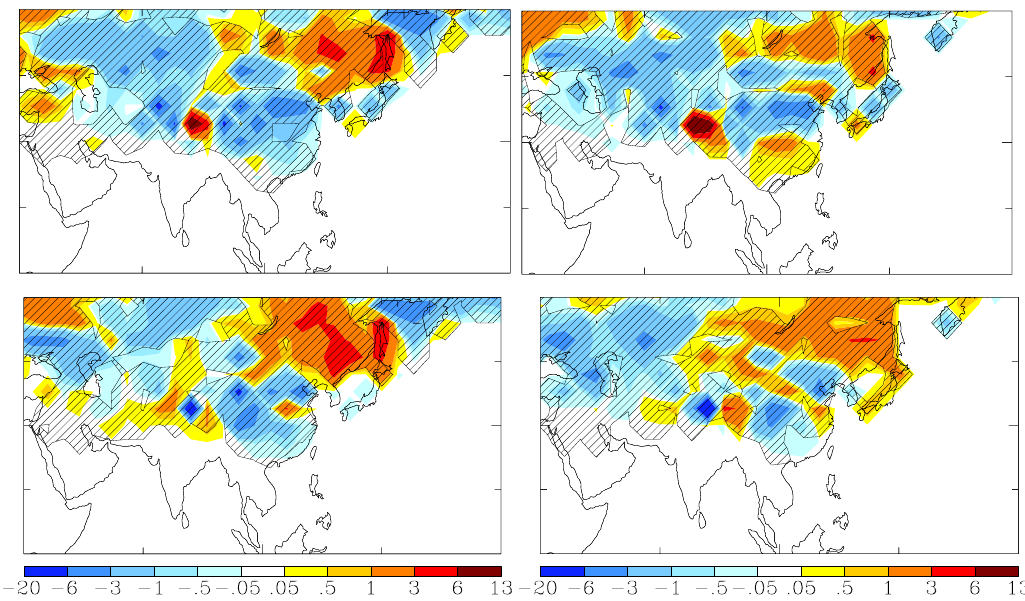
Fig. 2. Average difference in annual snow/ice cover (%) for differences in emissions between 2000 and 1990 with (left panel) and without (right panel) the climate influence for the Beig (top panels) and Bond (bottom panels) emissions. Simulations include the direct and indirect effects and changes in snow/ice albedo due to black carbon deposition on snow/ice surfaces. Differences that are significant at the 95% confidence level are indicated by hatched